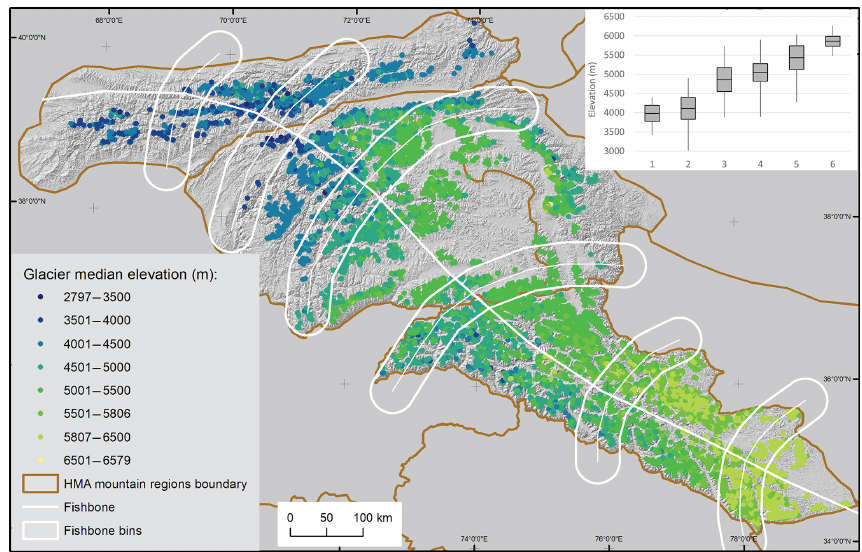
Figure 11. Glacier median elevation over the study area of glaciers larger than 0.5km 2 . The inset shows median elevation, standard devia- tions, and minimum and maximum elevations per